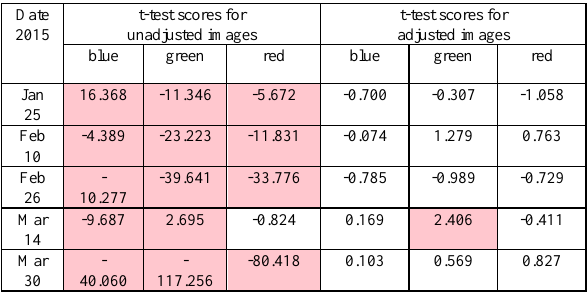
Table 2. The computed t-test scores of sample unadjusted and adjusted images from